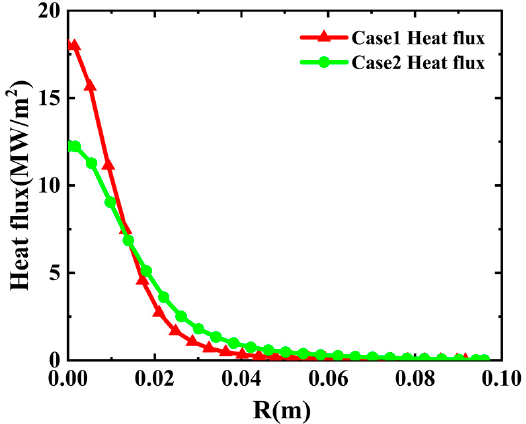
Figure 18. Radial heat flux distribution calculated by plasma parameters at Z = 1.33 m.